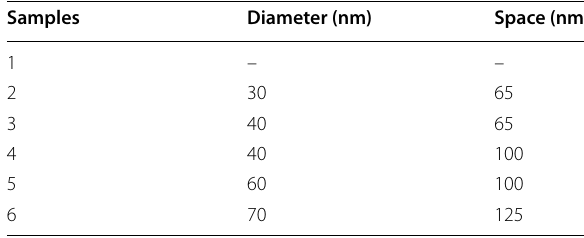
Table 1 The diameters and spaces of samples